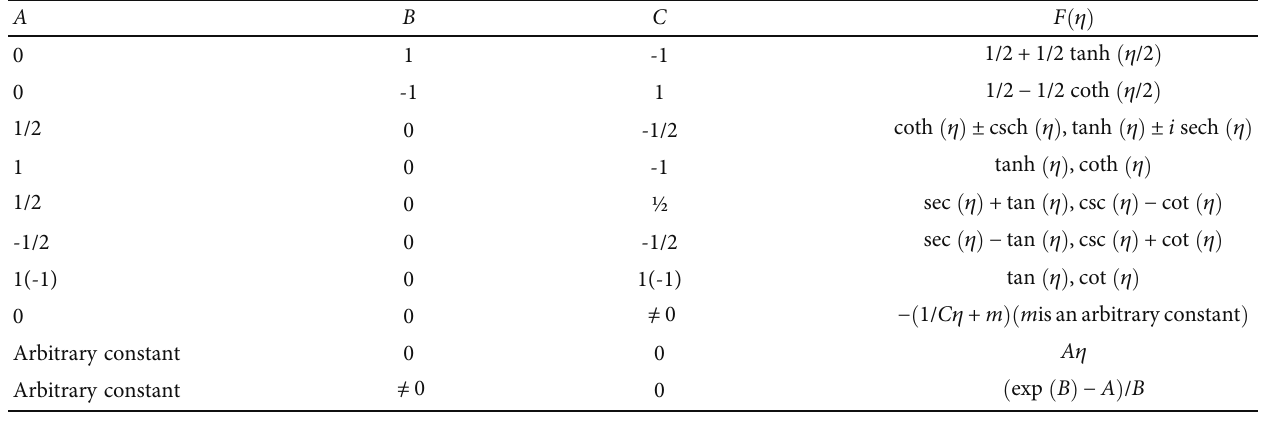
Table 1: Relations between A , B , C and corresponding F ð η Þ in Eq. (16) [34].